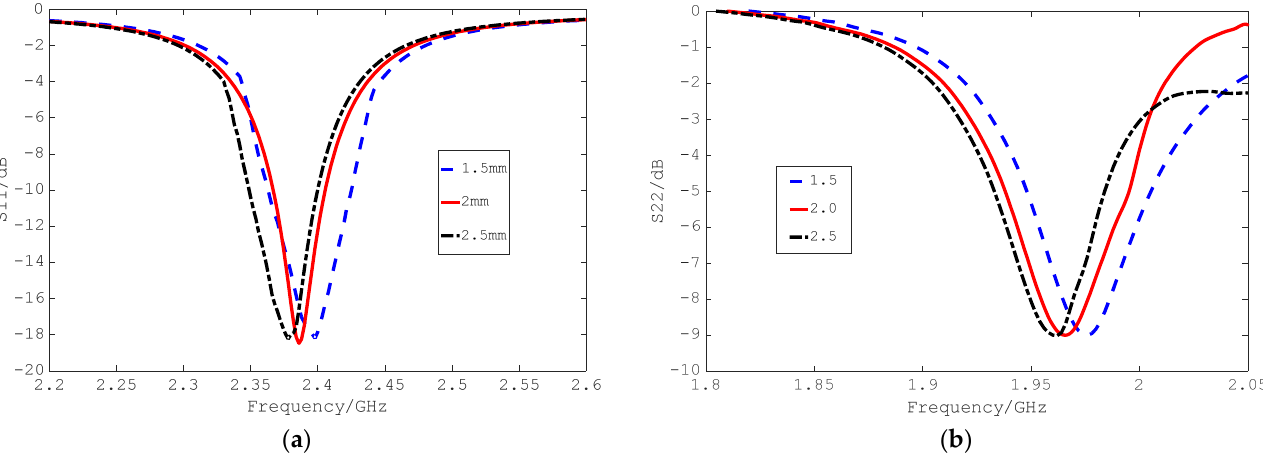
Figure 16. Measured reflection coefficient results of fabricated sensor for crack with different depths. ( a ) Port 1 to horizontal cracks. ( b ) Port 2 to vertical cracks.